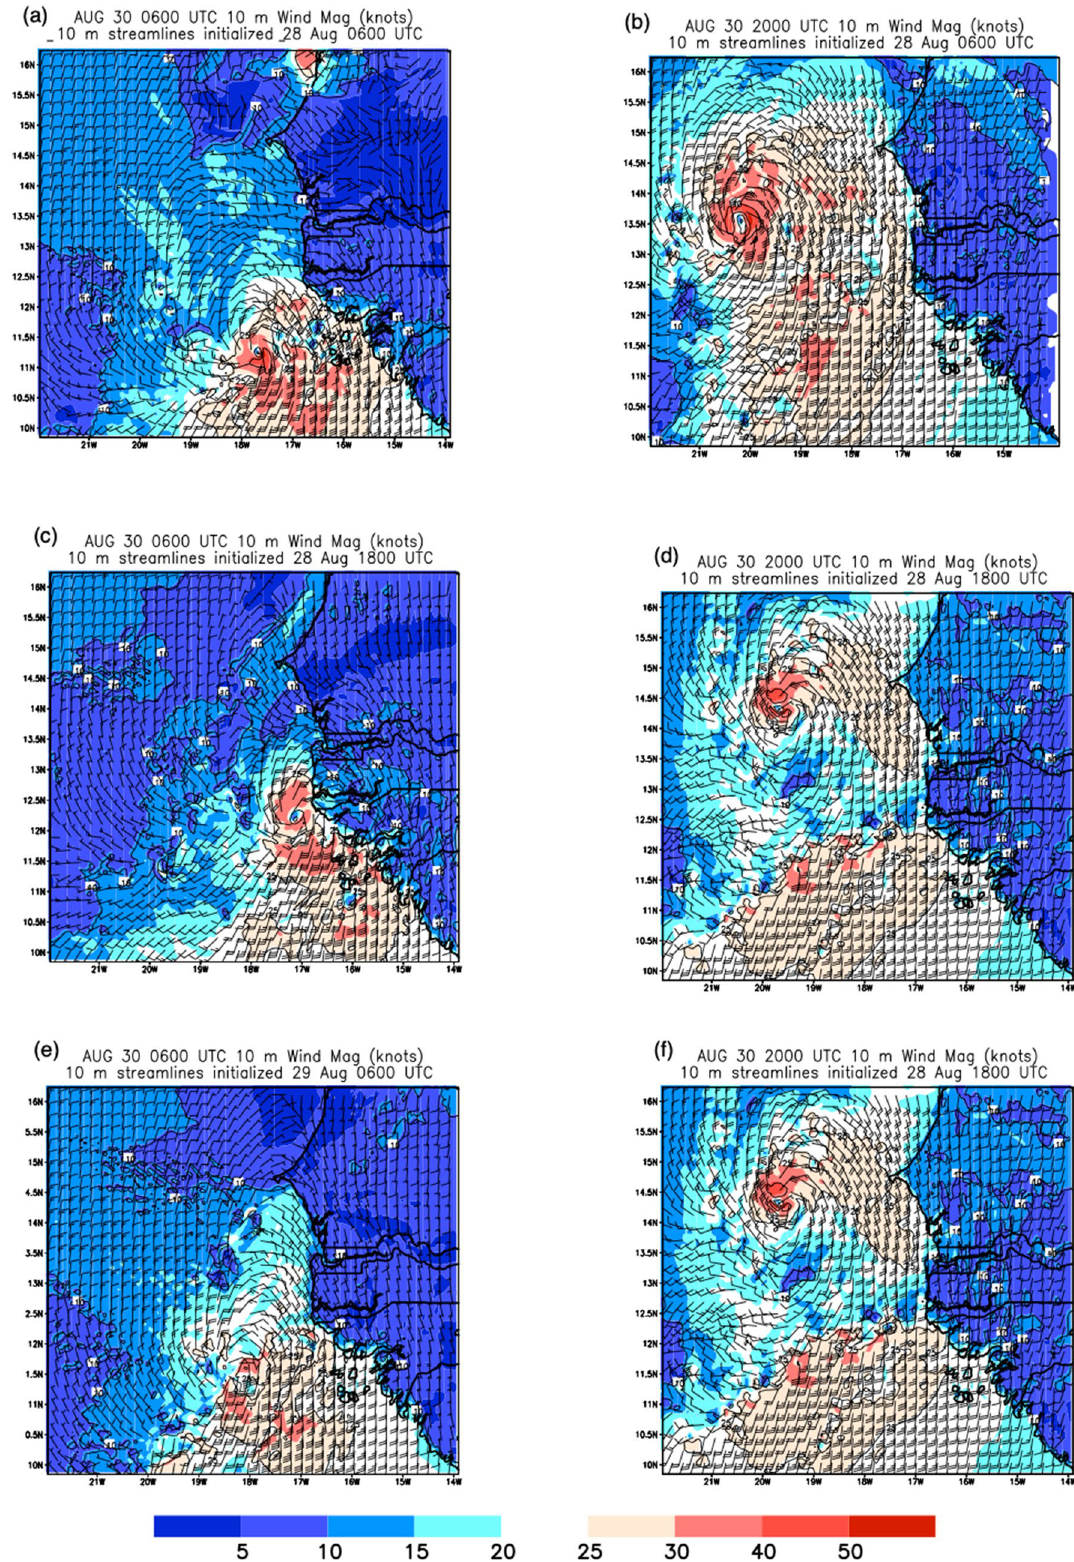
Fig. 5 Simulated 10 m-winds (color and arrows in kt) on 30 August 2015, respectively, from left to right at 0600 UTC and 2000UTC. Top for simulation 2A, middle for simulation 2B and bottom for simulation